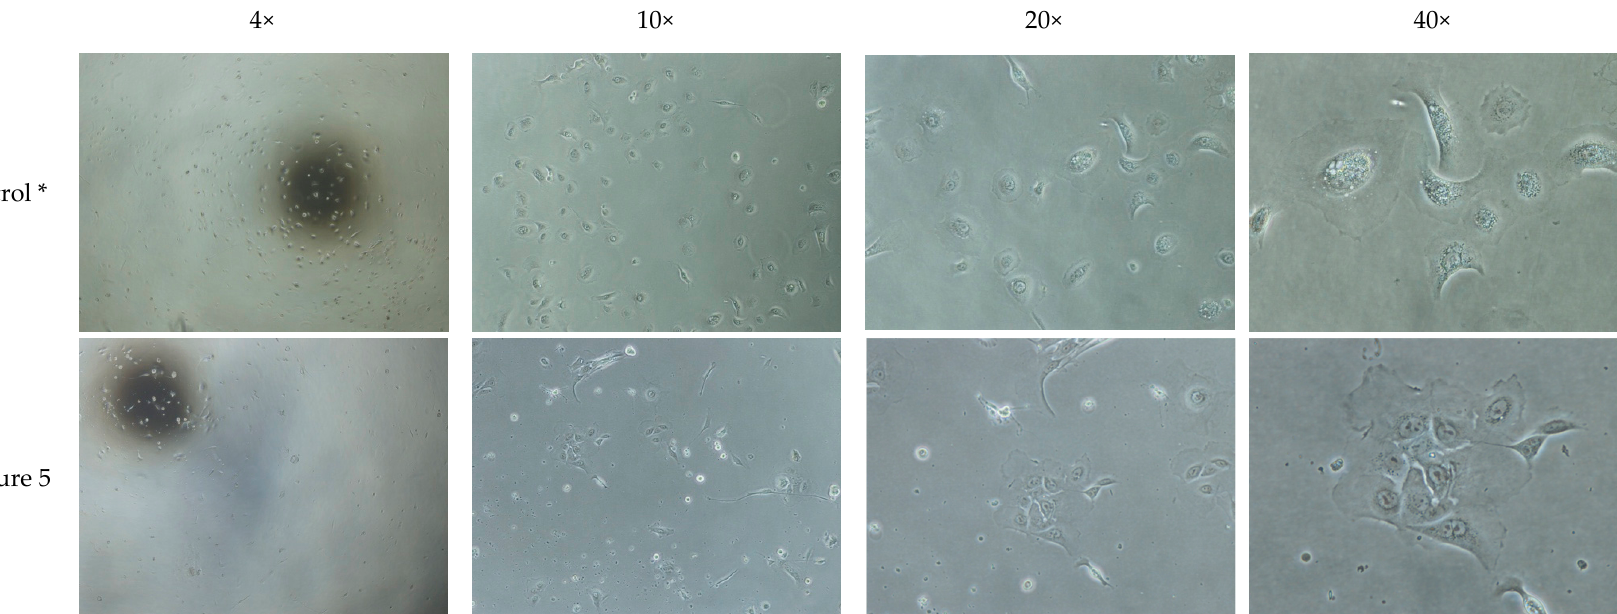
Figure 1. Light microscope images (4×, 10×, 20× and 40× magnification) of 1-day old culture of human OMECs on HA hydrogel scaffold mixture 5 coated with 1 mg/mL collagen IV. Cell attachment and morphology of OMECs on mixture 5 were better than other hydrogel scaffold mixtures. Therefore, it was selected for further optimization. * Cultured human OMECs on 1 mg / mL collagen IV coated plastic